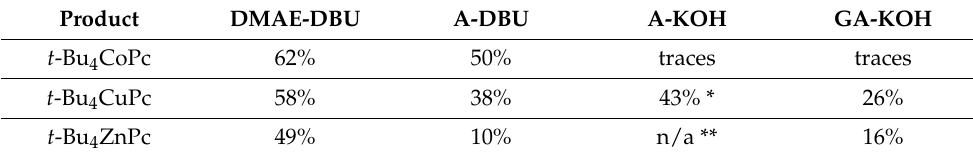
Table 2. Best-yielding reactions for the considered tetra- tert -butylphthalocyanines.